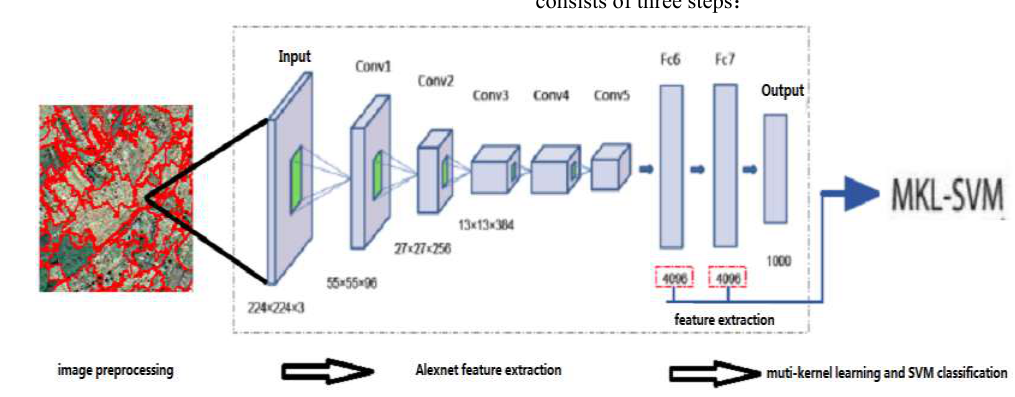
Figure 1. The flow chart of classification with deep features extraction by deep CNN